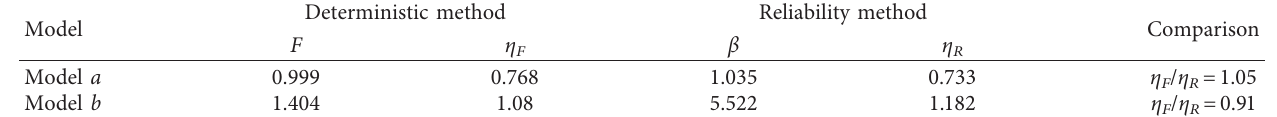
Table 6: Calculated results of the slope model.